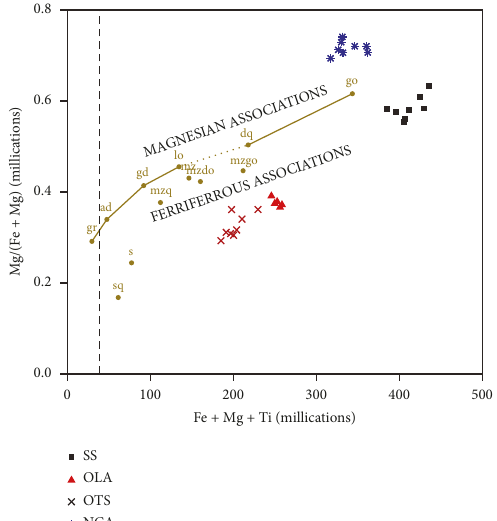
Figure 14: A plot of Fe+Mg+Ti against Mg/(Fe+Mg) as described in [43]. A line across the reference points, granite, adamellite, granodiorite, tonalite, quartz diorite, and gabbro is used to differentiate between magnesian and ferriferous associations. The dashed line presents leucogranites, which are granitic, light-colored igneous rocks with hardly any mafic minerals. Abbreviations: sq: quartz syenite, s: syenite, mzq: quartz monzonite, mz: monzonite, mzdq: quartz monzodiorite, mzgo: